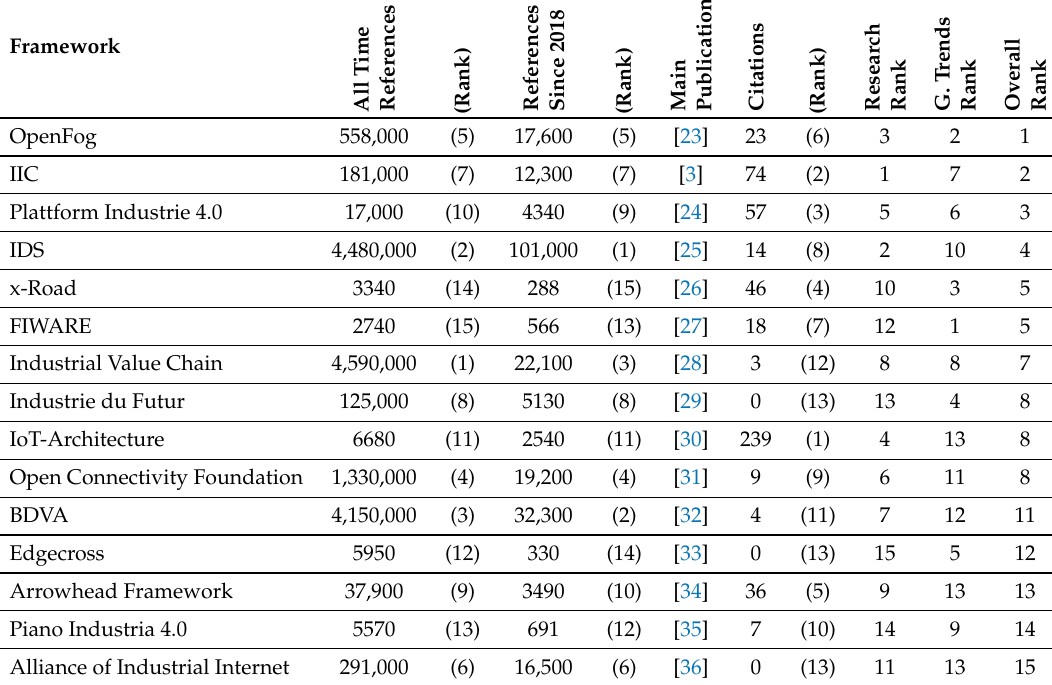
Table 1. Ranking of selected IIoT reference frameworks ranked by Google Scholar (research relevance) and Google Trends (public interest)